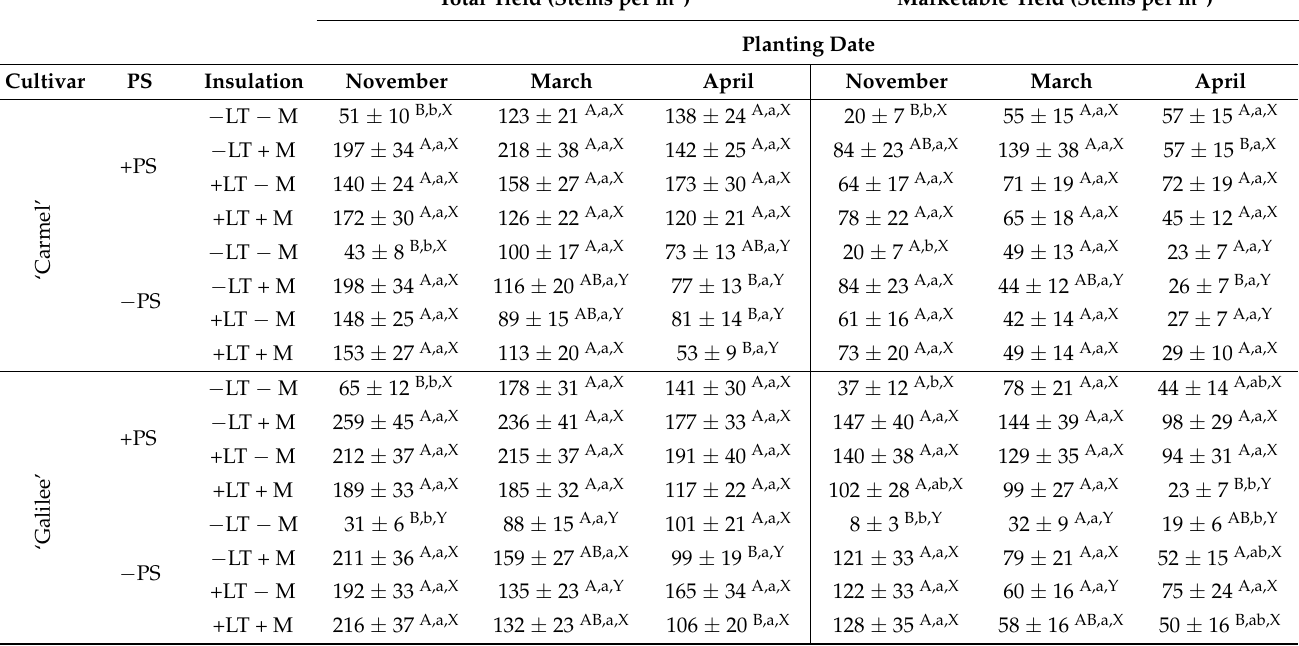
A, B: Planting date difference. For each type of yield, least squares means with the same letter within a row indicates no statistical difference at α = 0.05. a, b: Insulation difference. For each type of yield, least squares means with the same letter within a column under the same pre-sprouting indicates no statistical difference at α = 0.05. X, Y: Pre-sprouting difference. For each type of yield, least squares means with the same letter within a column under the same insulation indicates no statistical difference at α =